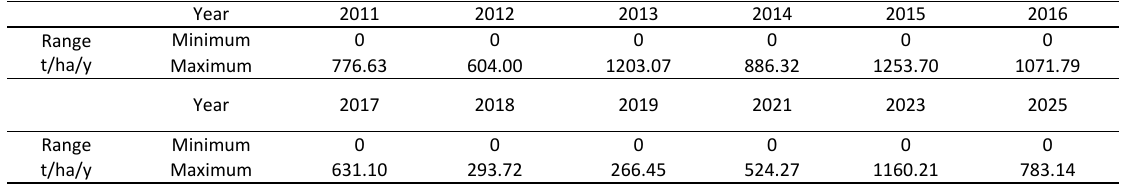
Table 6: Range of soil erosion rate from 2011 to 2025 (t/ha/y)